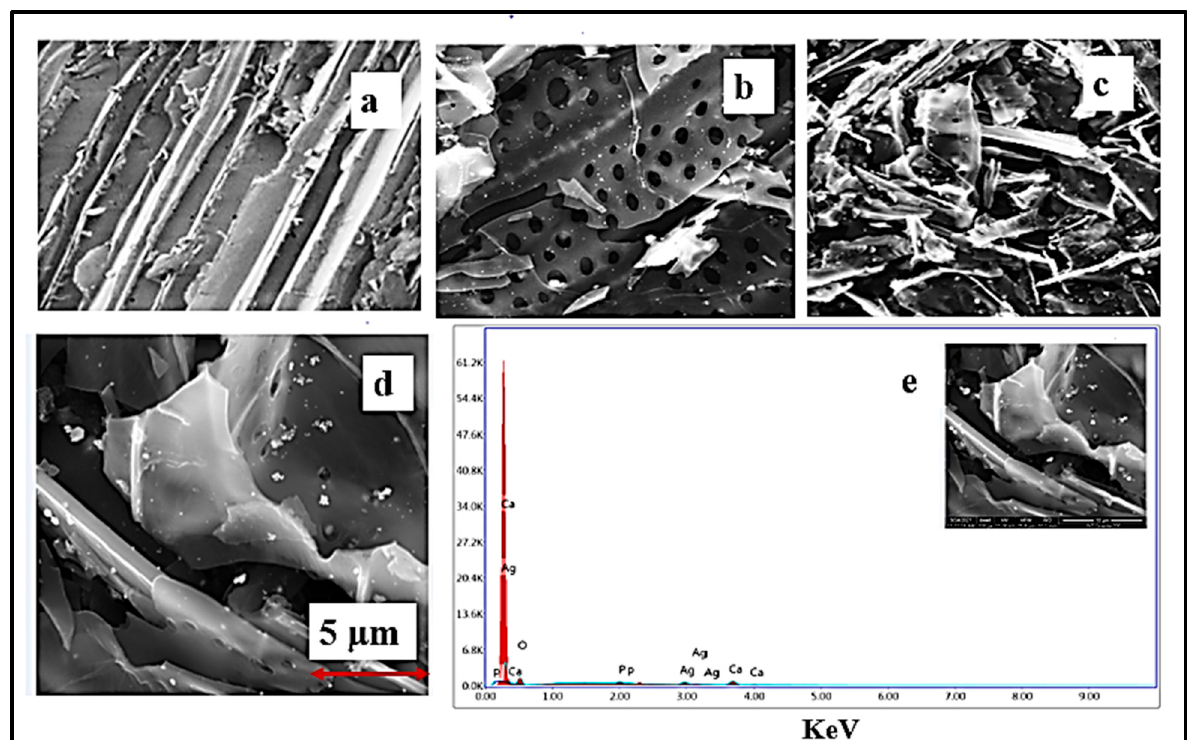
Figure 3. SEM images of ( a ) raw KF × 2000, ( b ) KAC × 2000, ( c ) CS ‐ KAC ‐ Ag × 2000, ( d ) CS ‐ KAC ‐ Ag × 5000, and ( e ) EDX spectra of CS ‐ KAC ‐ Ag. × 5000, and ( e ) EDX spectra of